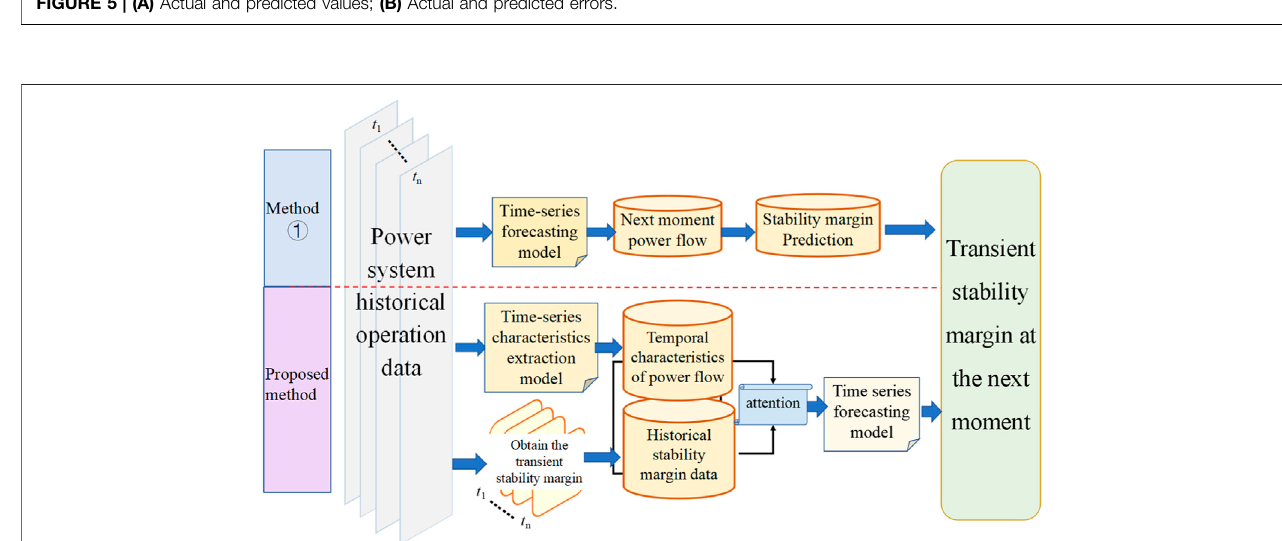
FIGURE 6 | Transient stability margin prediction method under the concept of security region.